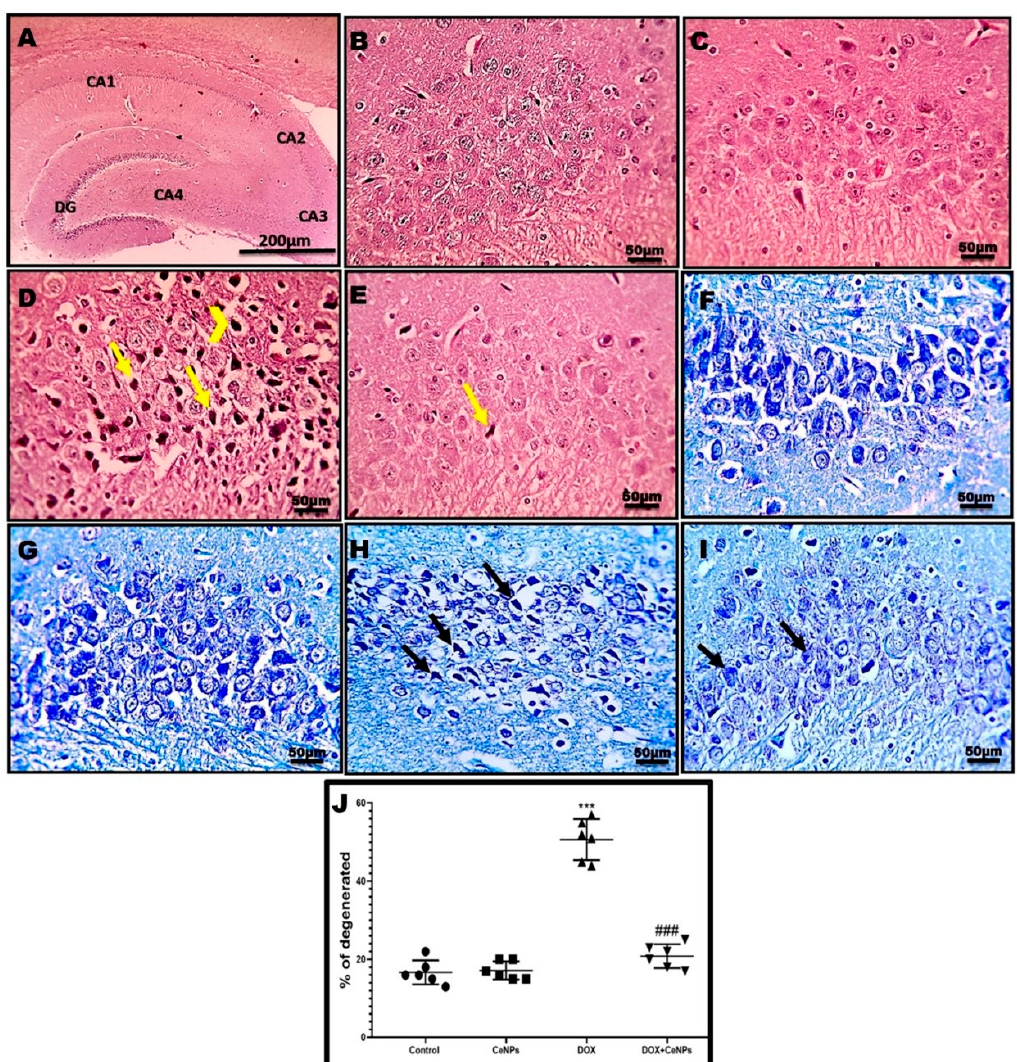
Figure 3. Effect of nanoceria on DOX ‐ induced histopathological alterations . Hippocampal sections stained with H&E . ( A ) Hippocampus of control rat showing the dentate gyrus (DG) and the four regions of hippocampus CA1, CA2, CA3 and CA4 (Magnification ×40, Scale bar = 200 μ m) ( B , C ) Normal neurons in pyramidal layer of CA3 region in both the control group and group that received CeNPs. ( D ) Hippocampal sections from the DOX group showed severe neuronal degeneration (yel ‐ low arrows) with prominent vacuolations (yellow arrowheads). ( E ) Hippocampal sections from treated group DOX + CeNPs showed very mild neuronal degeneration (yellow arrows). Magnifica ‐ tion ×400, Scale bar = 50 μ m. Hippocampal section stained with toluidine blue stain . ( F , G ) Hippo ‐ campal sections of control group and group which received CeNPs showing normal, blue ‐ stained neurons in pyramidal layer (CA3). ( H ) Hippocampal sections from DOX group showed increased bluish staining due to many degenerated neurons (black arrows). ( I ) Hippocampal sections from treated group DOX + CeNPs showed a decreased bluish staining due to fewer degenerated neurons (black arrows). ( J ) Histogram of toluidine blue staining across six different fields from 3 rats per experimental group expressed as % of degenerated neurons compared to the total number of neu ‐ rons. All data were expressed as mean ± SD. The analysis of the data was conducted employing one ‐ way ANOVA test followed by Tukey’s post hoc test, *** p < 0.001 vs. control group, ### p < 0.001 vs. DOX group. Magnification ×400, Scale bar = 50 μ m.